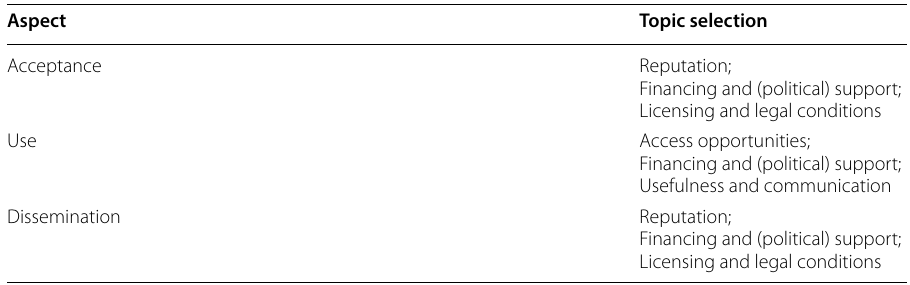
Table 11 Selected topics for the group discussions